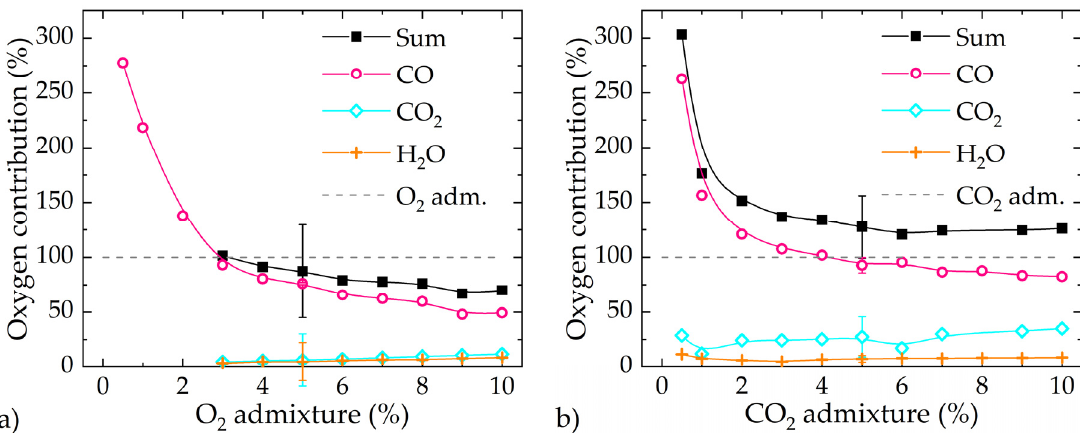
Figure 2. Normalized atomic oxygen contributions of the oxygen-containing species (CO, CO 2 , and H 2 O) and their sum related to the oxygen content in the precursor gas for ( a ) O 2 and ( b ) for CO 2 . T = 540 °C, N 2 + O 2 = 90% or N 2 + CO 2 = 90%, H 2 = 10%, P AS = 6.0 kW.